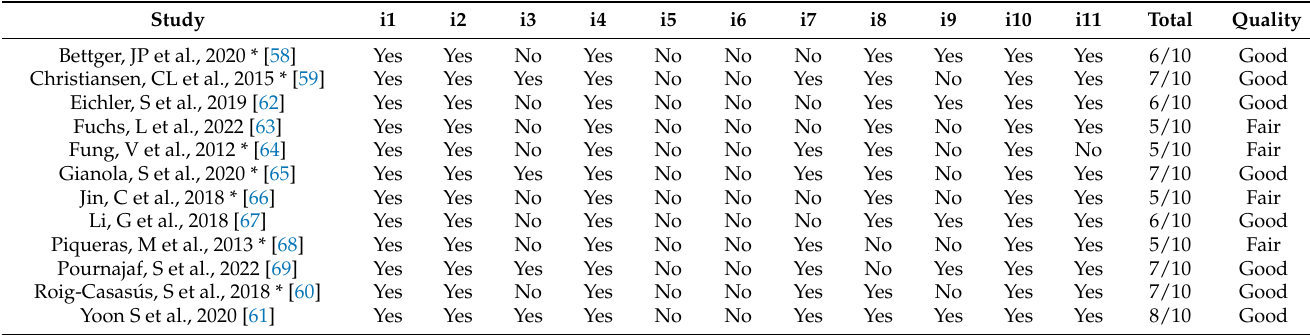
Table 3. PEDro Scale for methodological quality and risk of bias